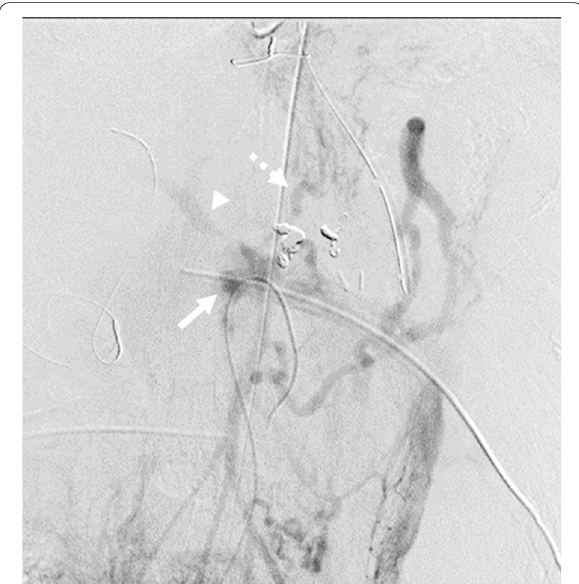
Fig. 7 Arterial portography at postoperative day 39. Extravasation of contrast medium from the right side of the superior mesenteric vein (arrow), faint visualization of the portal vein (arrowhead), and left gastric vein (dotted